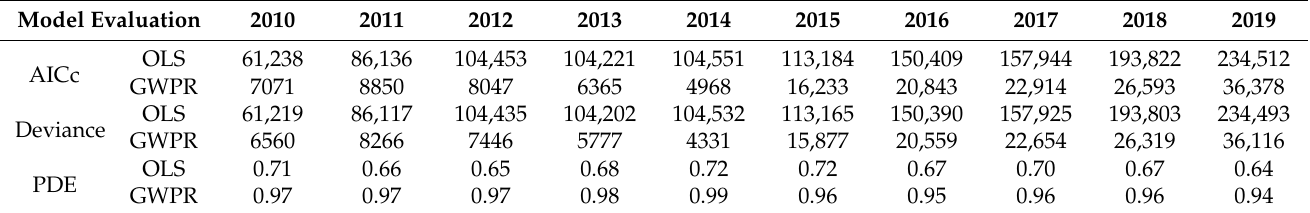
Table 1. Model evaluation between OLS regression and GWPR.